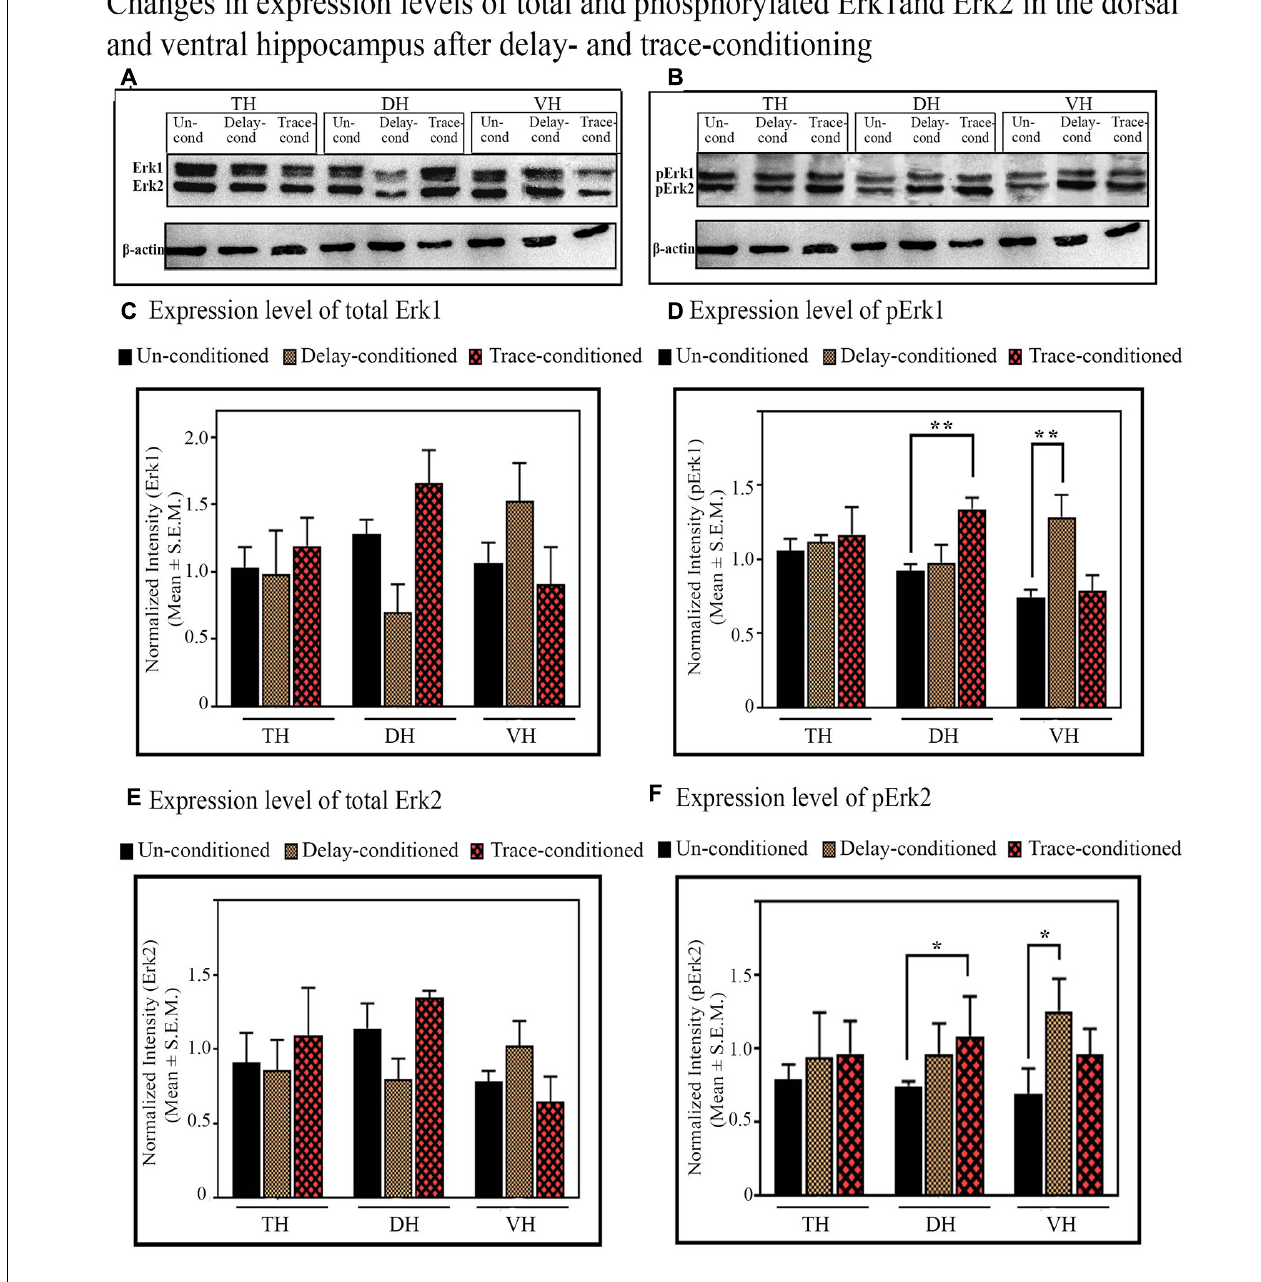
FIGURE 6 | The changes in the expression levels of total and phosphorylated Erk1 and Erk2 proteins after trace- and delay-conditioning in the total hippocampus (TH), dorsal hippocampus (DH) and ventral hippocampus (VH). (A) Immunoblots showing bands of Erk1, Erk2, and β -actin (loading control) in TH, DH, and VH. (B) Immunoblots showing bands of pErk1, pErk2, and β -actin (loading control) in TH, DH, and VH. The same β -actin blot [as is shown with Erk1, Erk2 in (A) ] is shown here along with pErk1 and pErk2 blots for comparison. (C) No significant difference was observed in the expression level of Erk1 among the groups in TH, DH, and VH. (D) The expression level of pErk1 did not change in the TH in the trace- and delay-conditioned animals, however, it significantly increased in the DH in the trace-conditioned animals (**Tukey p < 0.01, One way ANOVA; n = 6) and in the VH in the delay-conditioned animals (**Tukey p < 0.01, One way ANOVA; n = 6), compared to the un-conditioned control animals ( n = 6). (E) The expression level of Erk2 did not change significantly in the TH, DH, and VH, in the trace- and delay-conditioned animals compared to the un-conditioned control animals. (F) The expression level of pErk2 did not change in the TH, in the trace- and delay-conditioned animals. However, it significantly increased in the DH in the trace-conditioned animals ( n = 6), and in the VH in the delay-conditioned animals ( n = 6) compared to the un-conditioned group ( n = 6; *Tukey p < 0.05; One way ANOVA).